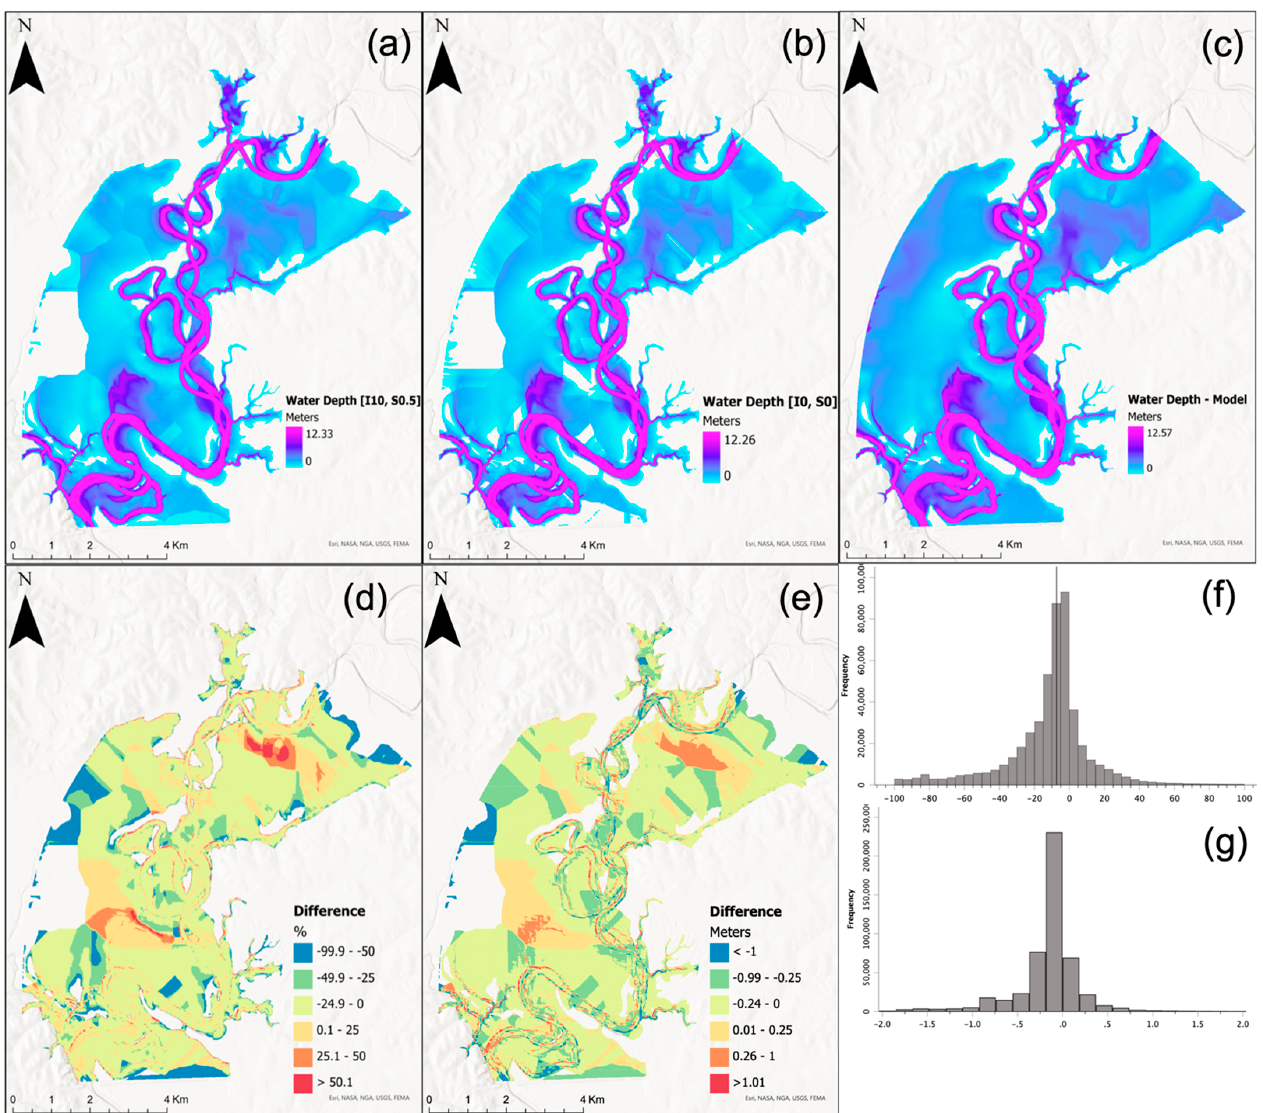
Figure 6. The May 2016 flood event for the Brazos River (Texas) case study: ( a ) FwDET2.1 [I10, S0.5] calculated floodwater depth; ( b ) FwDET2.0 [I0, S0] calculated floodwater depth; ( c ) benchmark water depth map (hydraulic simulation); ( d ) percent difference map [100([FwDET v2.1]–benchmark)/benchmark] (negative values are underpredictions by FwDET2.1); ( e ) difference map ([FwDET v2.1]–benchmark) (negative values are underpredictions by FwDET2.1); ( f ) histogram of grid-cell values of the percent difference map (%); ( g ) histogram of grid-cell values of the difference map (meters).